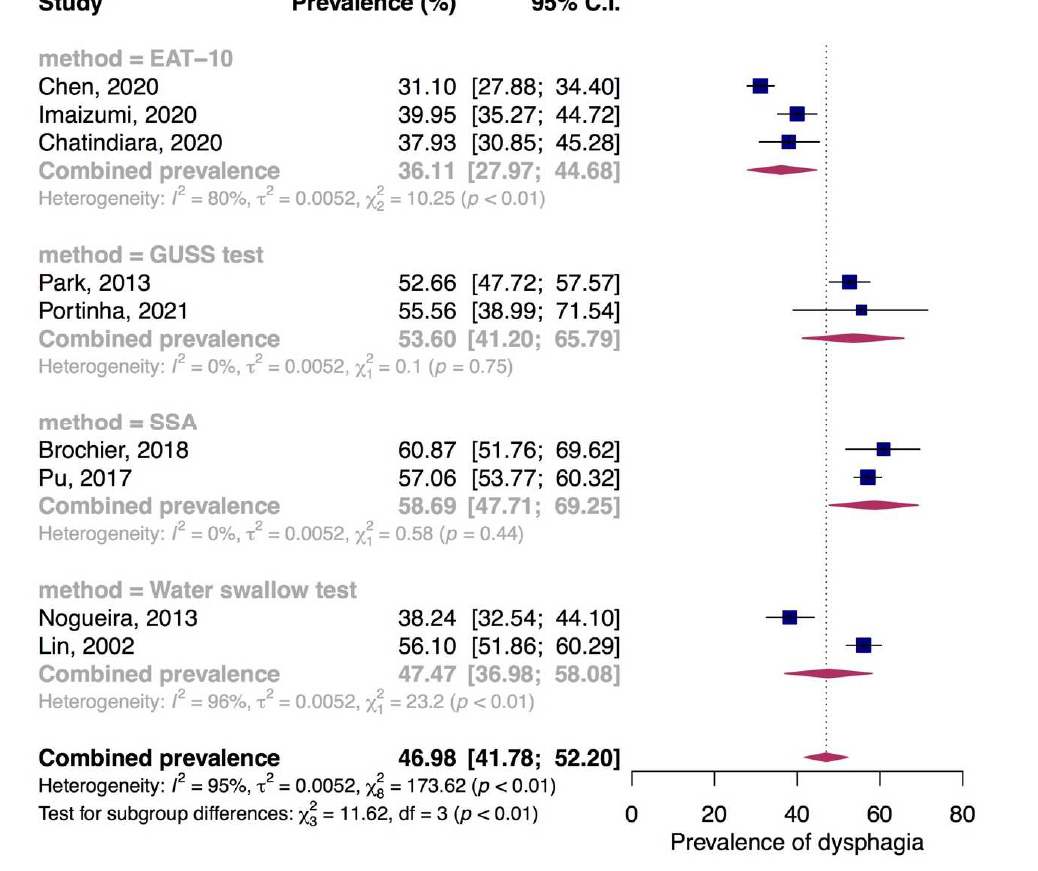
Figure 3. Prevalence of dysphagia in nursing home residents. EAT-10, 10-item Eating Assessment